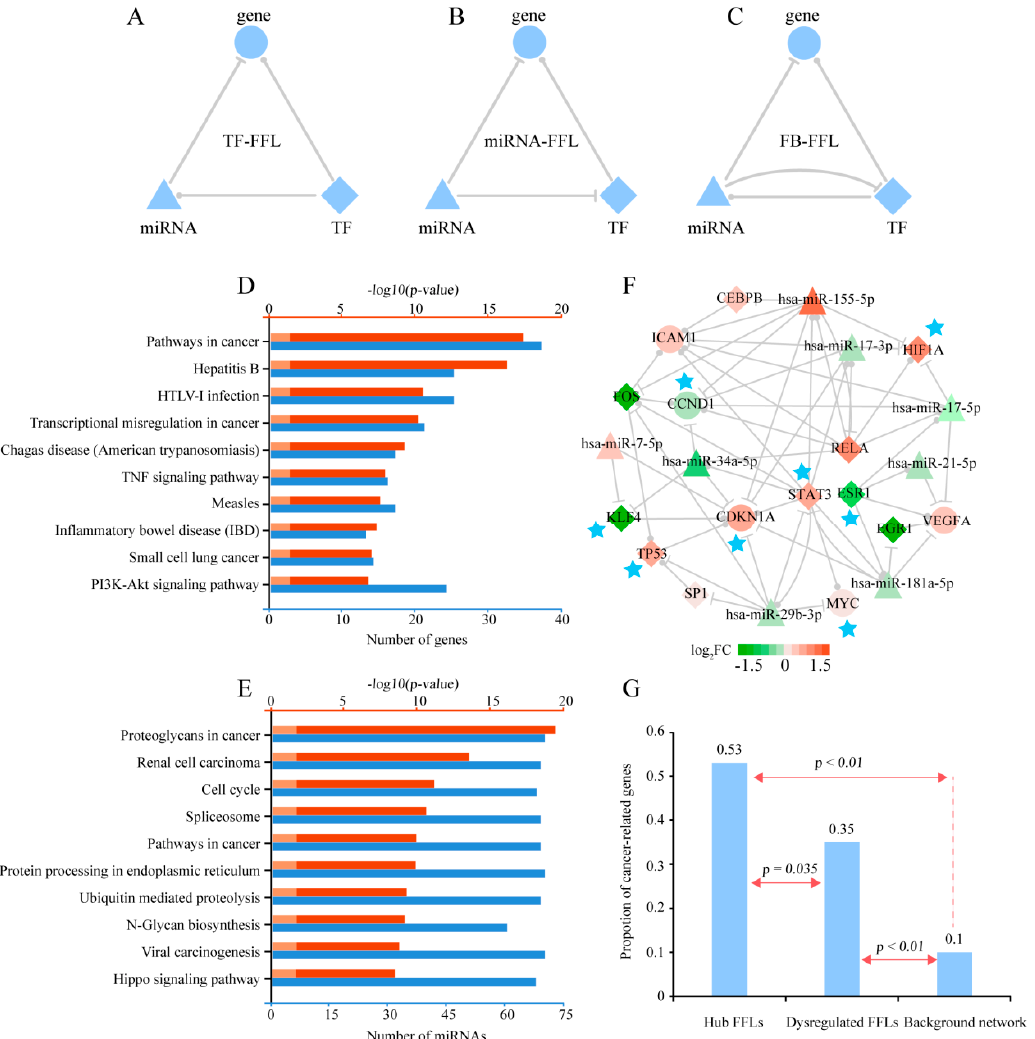
Figure 1. Three types of feed-forward loops (FFLs) and functional analysis of the dysregulated FFLs. ( A ). TF-FFL: transcription factor (TF) and microRNA (miRNA) regulate gene; TF regulates miRNA. ( B ). miRNA-FFL: TF and miRNA regulate gene; miRNA regulates TF. ( C ). FB-FFL (feed-back FFL): TF and miRNA regulate gene; TF and miRNA mutually regulate each other. Pathway enrichment analysis for genes ( D ) and miRNAs ( E ) in the dysregulated FFLs, respectively. The length of blue and red bar represents the number of genes (miRNAs) and –log10( p -value), respectively. The pink bar represents p -value = 0.05. ( F ). Dysregulated hub FFL subnetwork. Red and green represent upregulation and downregulation, respectively. The darker color represents larger | log 2 FC | value. The diamond, triangle and circular node represent TF, miRNA and gene, respectively. The blue stars indicate the known cancer genes. ( G ). Proportion of the known cancer genes in the hub FFL network, dysregulated FFL network and background regulatory network.